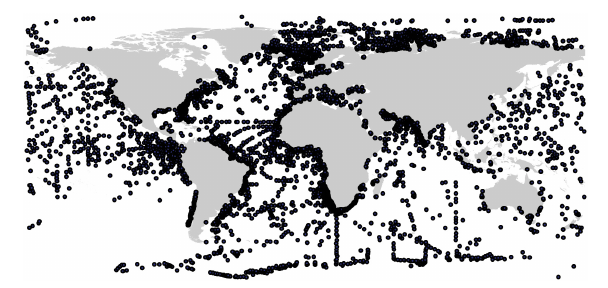
FIGURE 1 | Sediment core locations. Black dots represent the locations where sediment cores for marine sedimentary carbon were